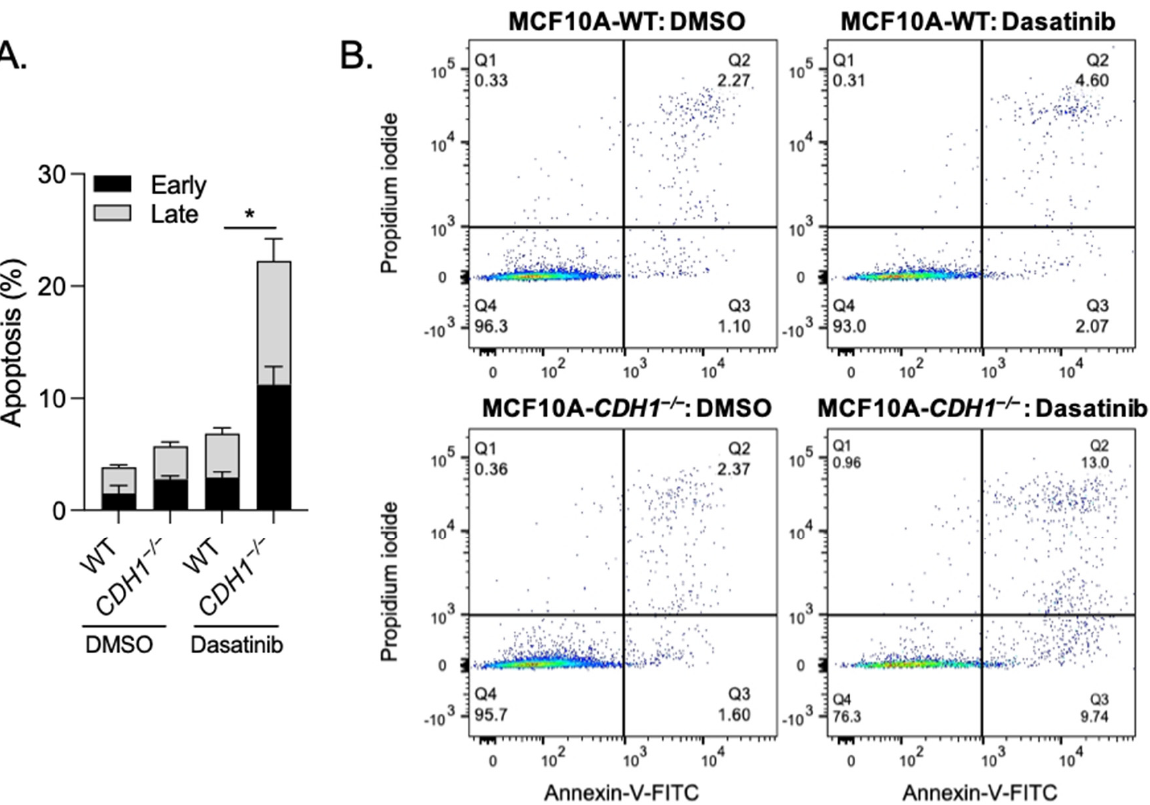
Figure 2. Dasatinib induces apoptosis in mammary cells lacking E-cadherin. ( A ) Total apoptosis (Annexin-V-FITC and propidium iodide positive cells) (early + late apoptosis) detected by flow cytometry after 72 h drug treatment. ( B ) Representative histograms of MCF10A-WT and CDH1 − / − cells stained with Annexin-V-FITC and propidium iodide and analysed on BD Fortessa flow cytometer. Q4; live cells, Q3; early apoptotic cells and Q2; late apoptotic cells. (For bar graph, error bars = SEM; * p < 0.05; n ≥ 3 independent biological replicates; unpaired two-sided t -test).